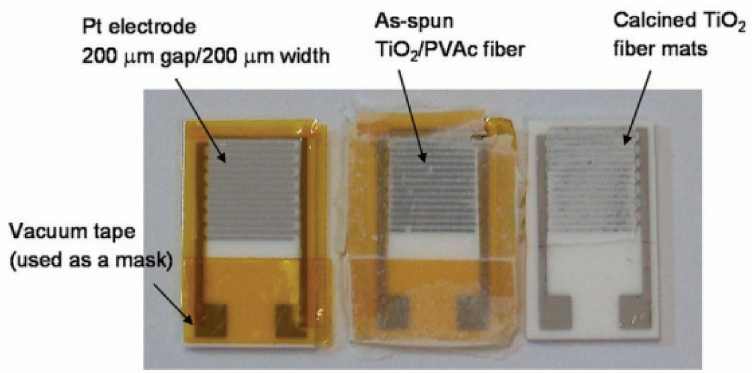
Figure 31. Optical micrographs of gas sensor test devices (10 × 15 mm) with TiO 2 nanofiber mats after different processing steps. Reprinted with permission from [348]. Copyright 2006